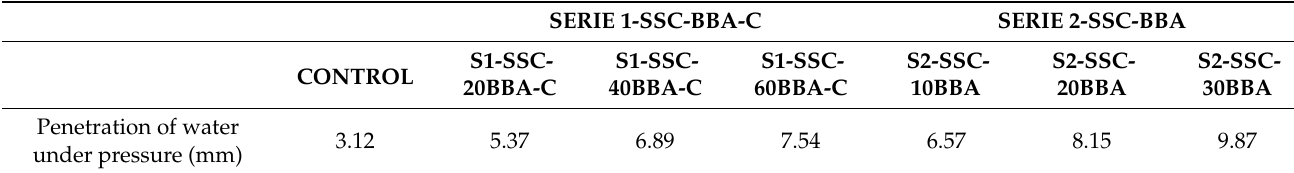
Table 8. Penetration of water under pressure (mm).